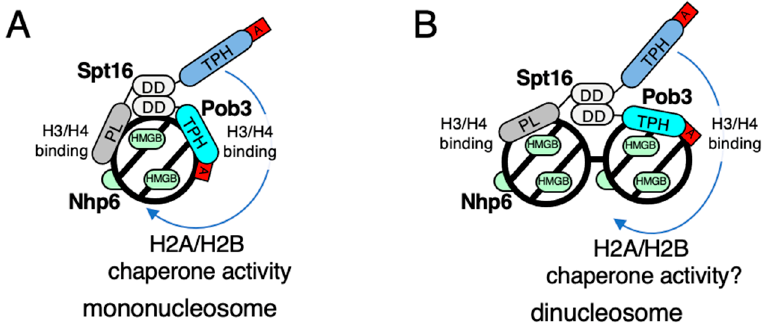
Figure 2. FACT working model for the mononucleosome and dinucleosome. PL: peptidase-like domain, TPH: tandem PH domain, DD: dimerization domain, A: acidic cluster. ( A ) Yeast FACT on mononucleosome. FACT functions as a histone chaperone in this scenario. ( B ) Yeast FACT on dinucleosome. Whether FACT functions as a histone chaperone in this scenario remains unknown.